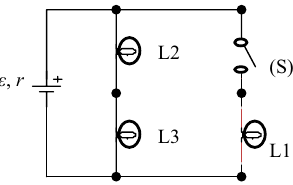
Fig. 12. The variation of the lamps